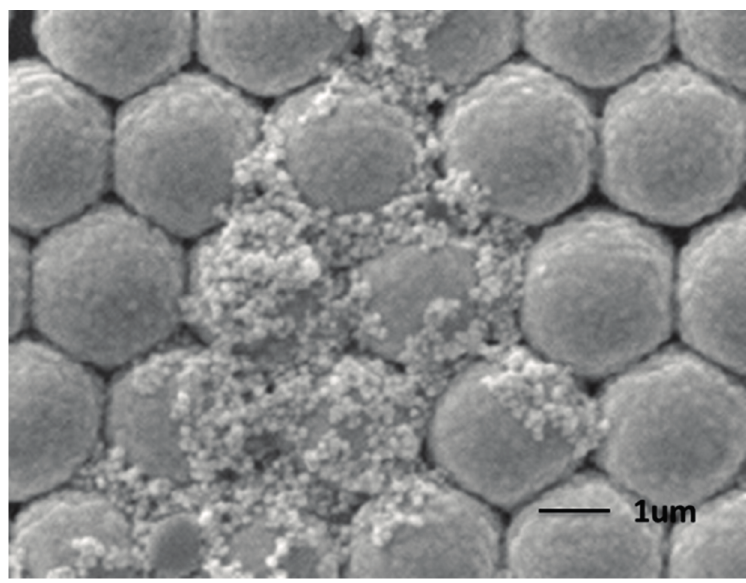
Figure 4. FE-SEM images of the silver nanoparticles (AgNPs)/AuFON